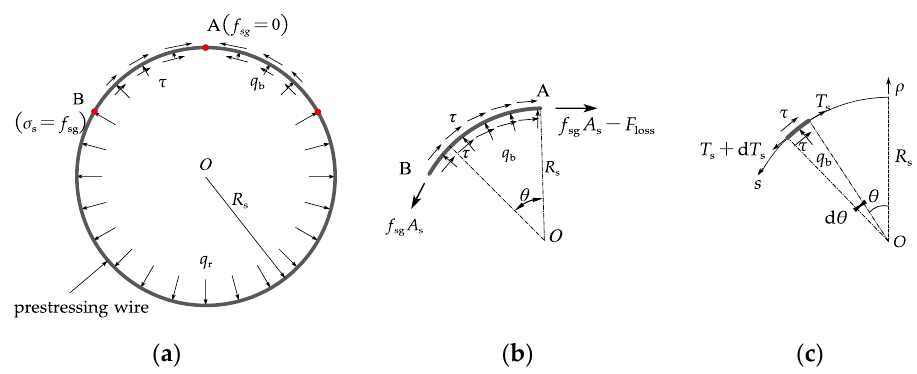
Figure 3. Force analysis diagram after a wire breaks: ( a ) Broken wire; ( b ) Stresses within the prestress loss zone; ( c ) An infinitesimal body.